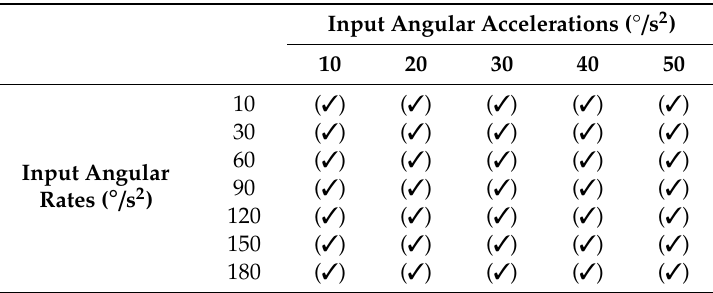
Table 2. Response validation experiments on a PIVG.